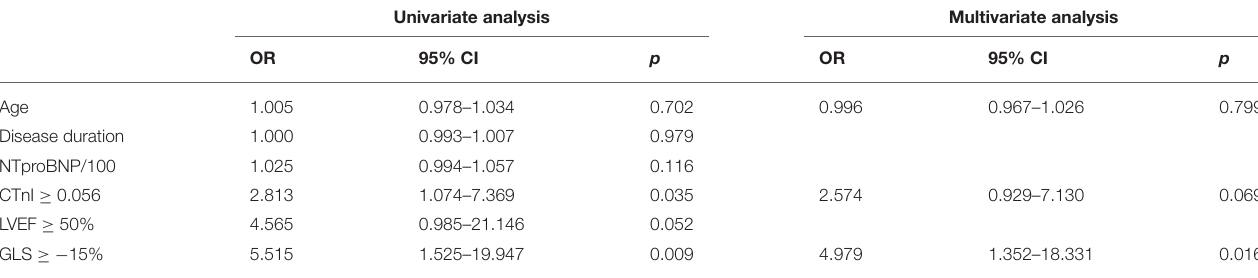
TABLE 3 | Univariate and multivariate logistic models for predicting the presence of LGE.